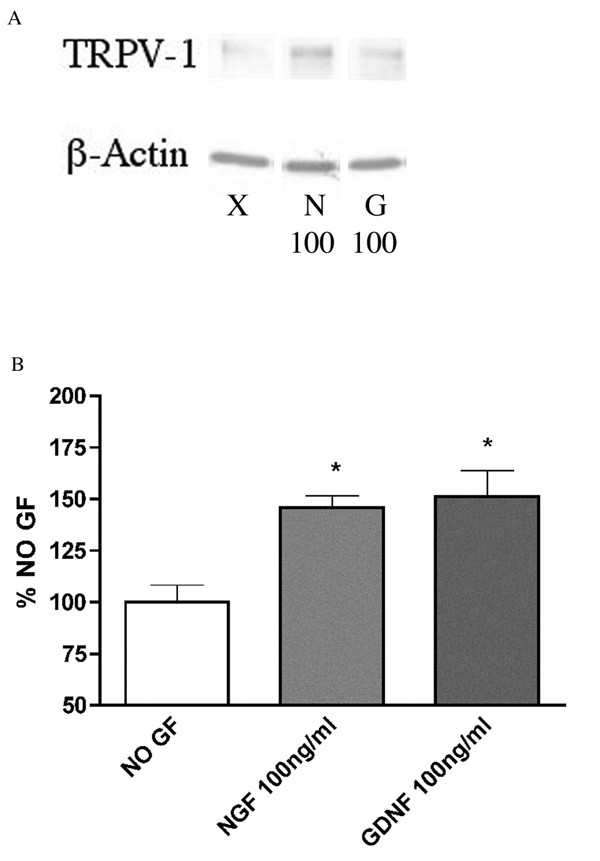
Assessment of TRPV1 protein by Western Blot. Panel A, 20 μg total protein was electrophoretically seperated per lane and transferred to membranes that were subsequently probed with an anti-TRPV1 antibody and then reprobed for standardization with β-actin (X = no growth factor; N 100 = NGF 100 ng/ml; G 100 = GDNF 100 ng/ml). Image is of a representative Western blot. Immunoreactivity to a protein corresponding to the size of the glycosyated form of TRPV1 was detected at ~130 kD. Panel B depicts alterations in TRPV1 protein levels standardized to β-actin (* p < 0.05, n = 3)